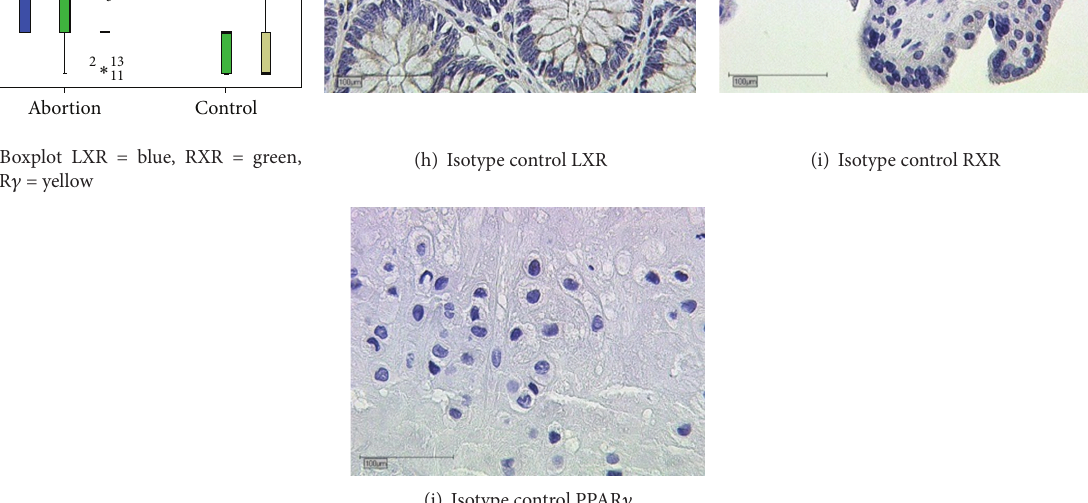
Figure 3: Serial sections of LXR ((a), (b)), RXR 𝛼 ((c), (d)), and PPAR 𝛾 ((e), (f)) expression in the syncytiotrophoblast of placentas from regular pregnancies ((a), (c), (e)) and in placenta of miscarriage ((b), (d), (f)). All magnifications are 20x lens. Box plots represent the LXR, RXR 𝛼 and PPAR 𝛾 expression in the placental syncytiotrophoblast of spontaneous abortion and control placentas derived from serial sections (g). (h), (i), (j) show isotype control for LXR, RXR 𝛼 , and PPAR 𝛾 . The boxes display the range between the 25th and 75th percentile and the horizontal line indicates the median. The bars represent the 5th and 95th percentiles. Circles indicate values which are more than 1.5 times the box length. Asterisks indicate values which are more than 2 times the box